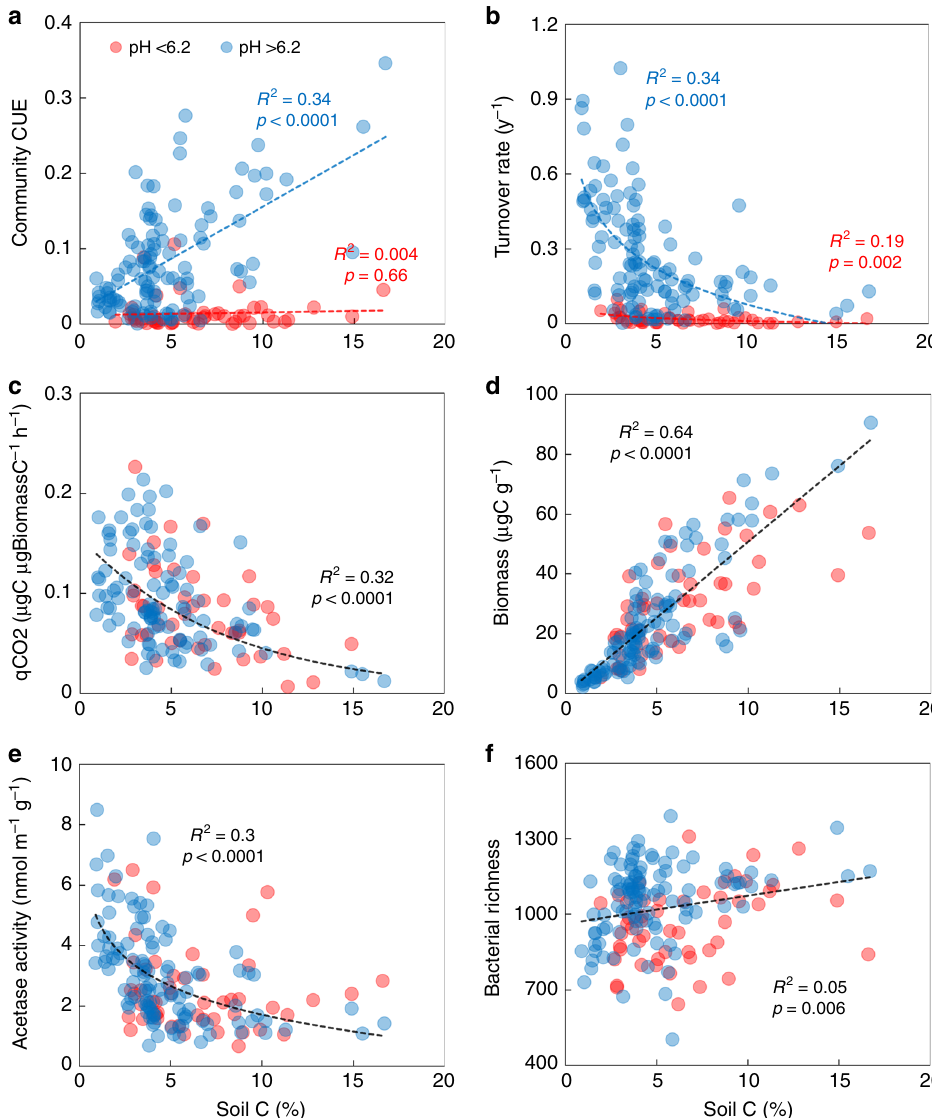
Fig. 2 Relationship between microbial parameters and soil carbon. Regression trends of microbial community CUE – carbon use ef fi ciency ( a ), turnover or growth rate ( b ), biomass-speci fi c respiration or qCO2 ( c ), DNA-C concentrations as biomass proxy ( d ), extracellular enzyme investment ( e ), and bacterial taxonomic richness ( f ) with SOC concentrations across the landscape-scale gradient of soils. Data from all 56 sites with three replicates at each site are presented here as independent points (red circles: pH < 6.2; blue circles: pH > 6.2). In c – f , there were no partitioning of microbial traits across the threshold pH value of 6.2, and the black regression lines include all data points. Best- fi tting regression models were: a pH < 6.2: n = 50, y = 0.0004 x + 0.01 and pH > 6.2: n = 113, y = 0.01 x + 0.02; b pH < 6.2: y = − 0.02 ln( x ) + 0.05 and pH > 6.2: y = − 0.21 ln( x ) + 0.55; c all data: n = 163, y = 0.16e − 0.12 ×